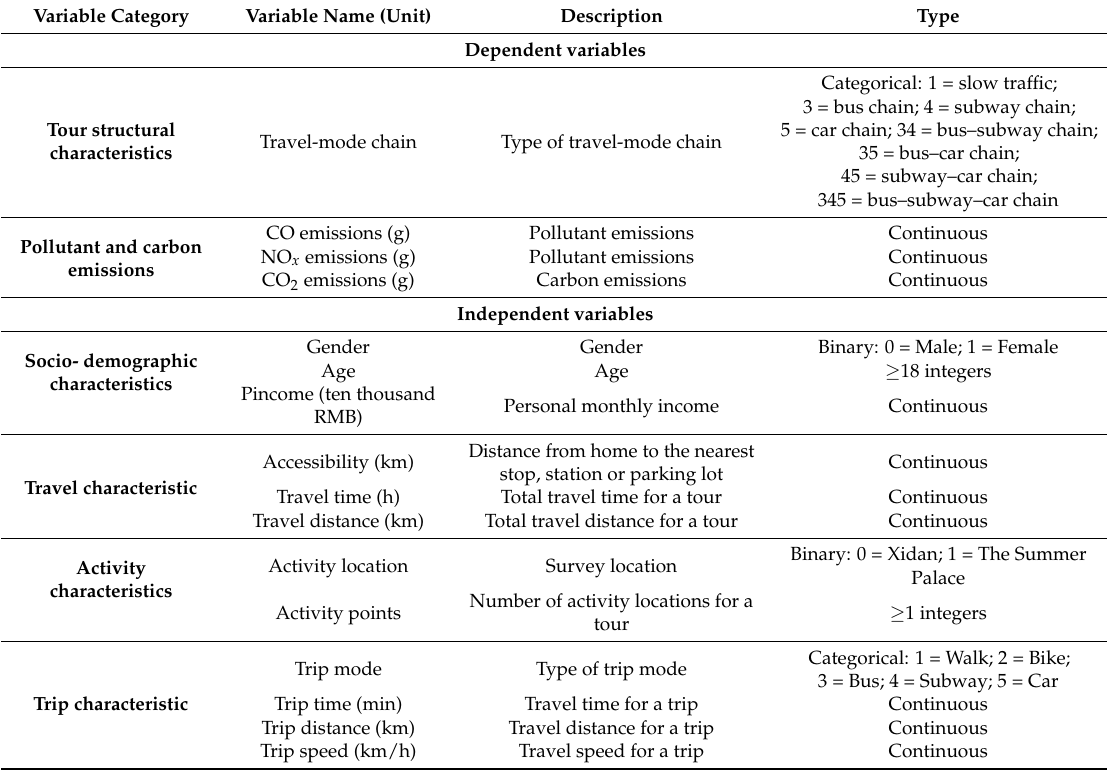
Table 4. Definition of